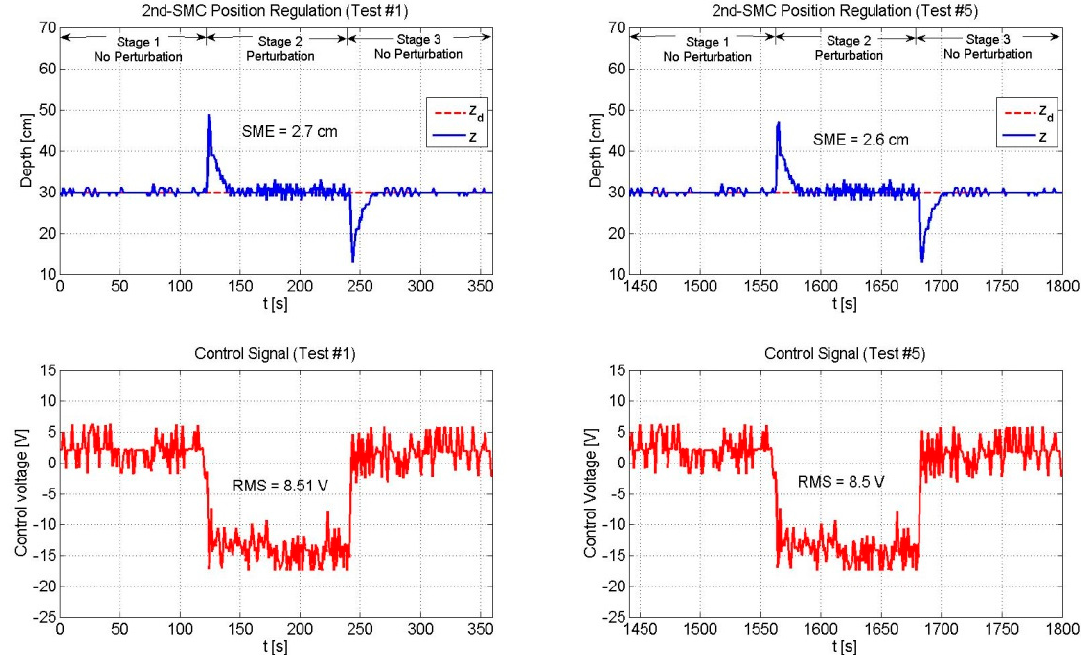
Figure 8. Performance of the 2nd-SMC scheme. The SME and the RMS values remained constant during the whole experiment.